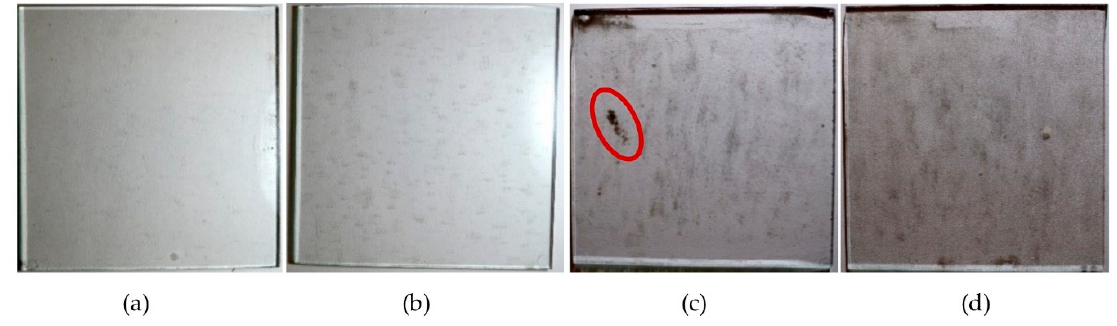
Figure 11. Uncleaned A coupons after removal at week 8 ( a ) uncoated, ( b ) coated, and at week 24 ( c ) uncoated and ( d ) coated. Images had contrast enhanced by 2% to make the staining more visible. The circled feature is a bird dropping. The soiling becomes more visible with increasing time of outdoor exposure.